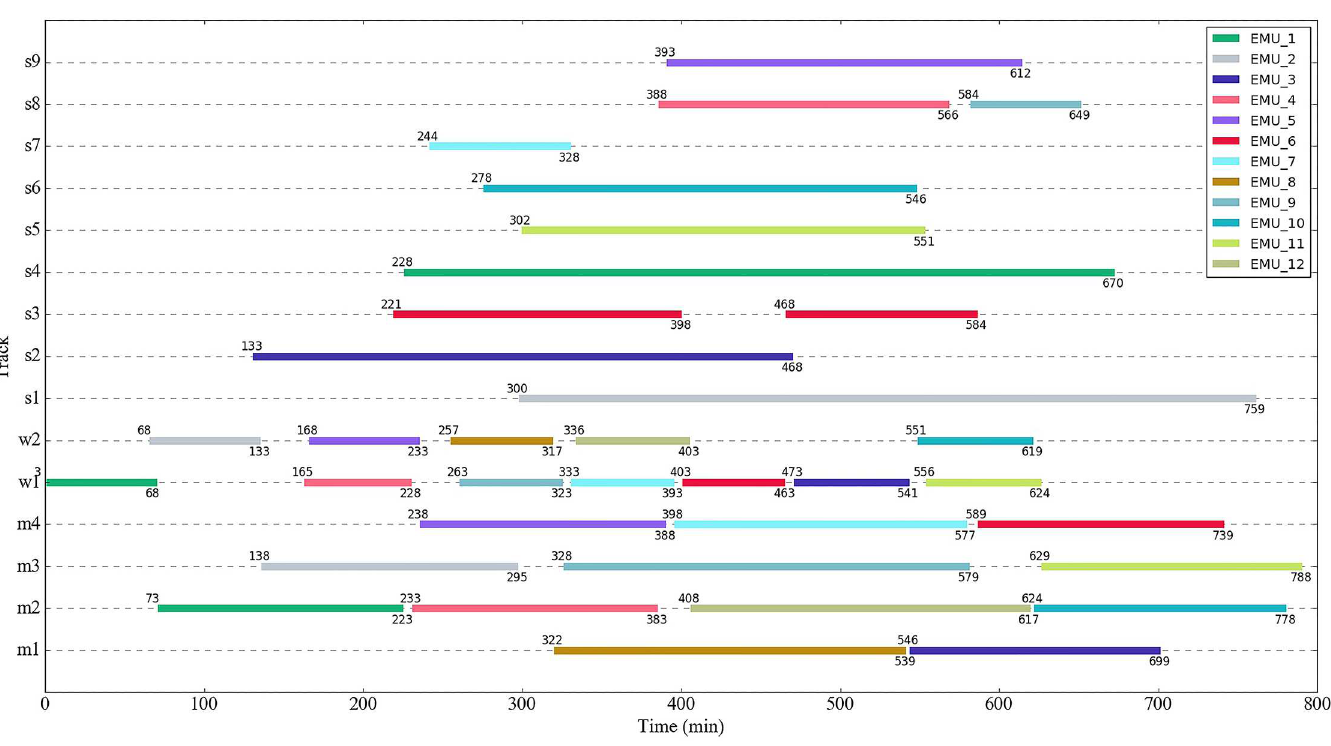
black box and merge the driver’s walking effort into the driver’s driving effort. The shunting driver assignment plan aims to design an optimal partition of the set of shunting tasks and optimal connections of shunting tasks for each resulting subset while satisfying various opera- tional requirements.